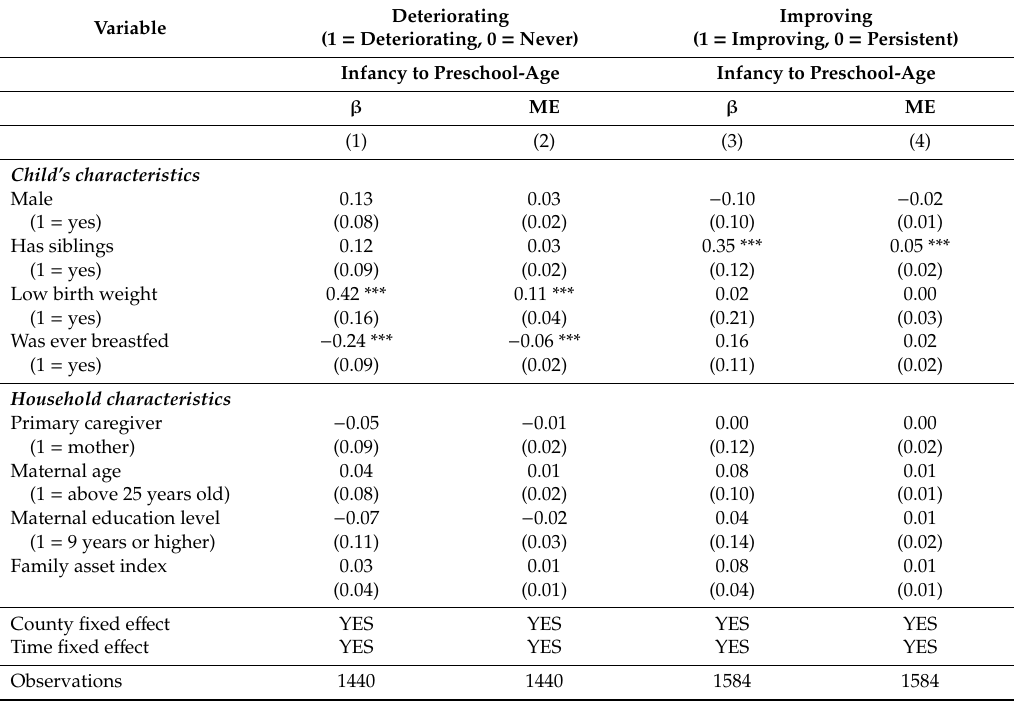
Table 5. Multivariate analysis of the association between characteristics and anemia status.